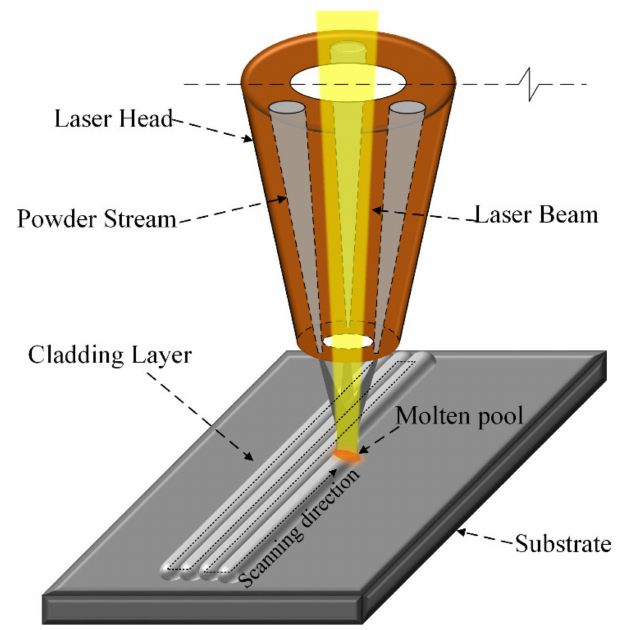
Figure 1. Schematic of the multi-track coaxial laser cladding